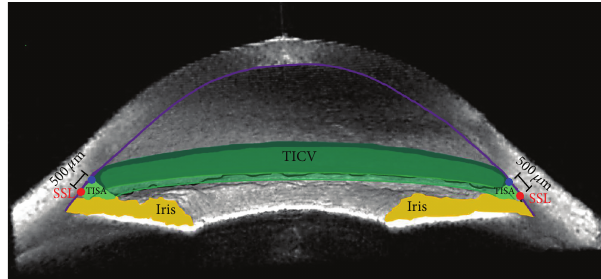
Figure 1: Trabecular-iris circumference volume (TICV). 3D ante- rior segment optical coherence tomography (ASOCT) image exhibiting TISA500 (light green space) and TICV500 (darker green spaces), along with the scleral spur landmark (red circle), iris (yellow), and cornea (violet line).